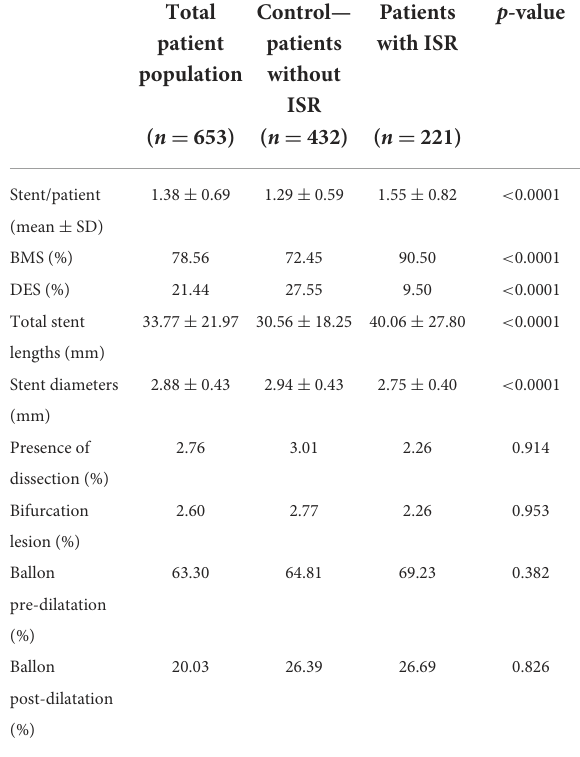
TABLE 2 Index PCI-related parameters in the patient